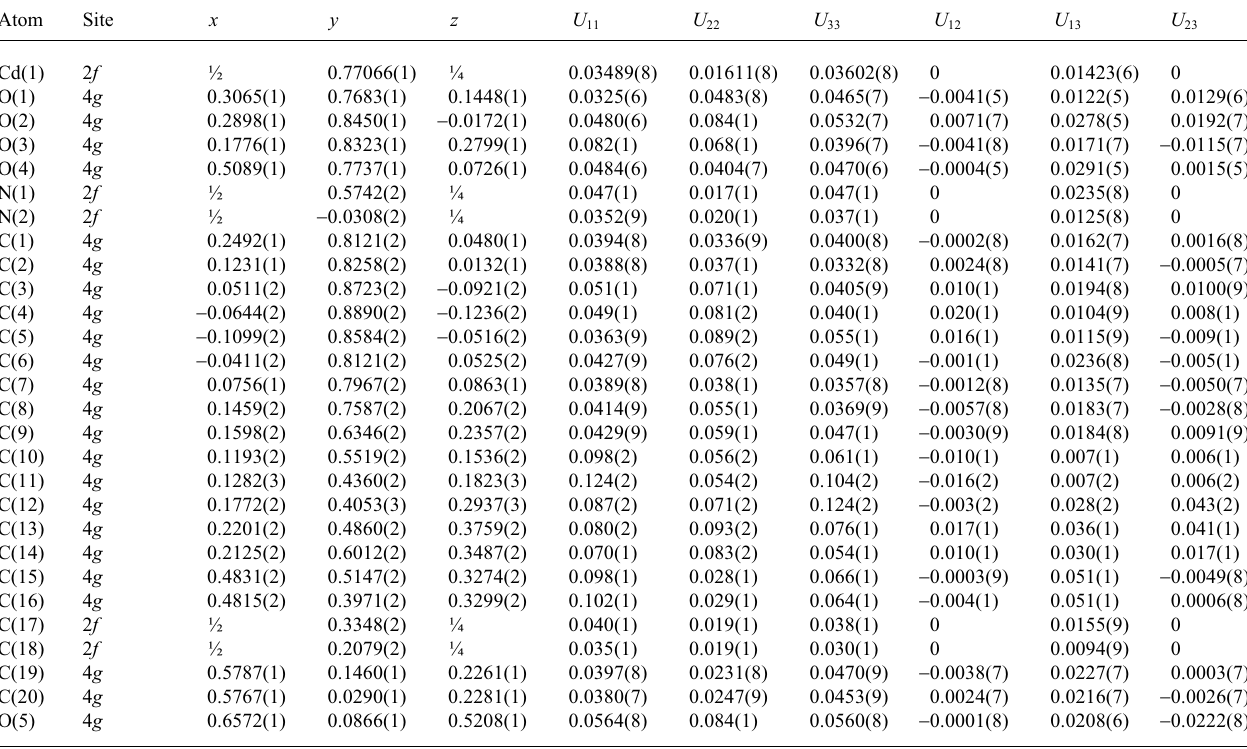
Table 3. Atomic coordinates and displacement parameters (in Å 2 )